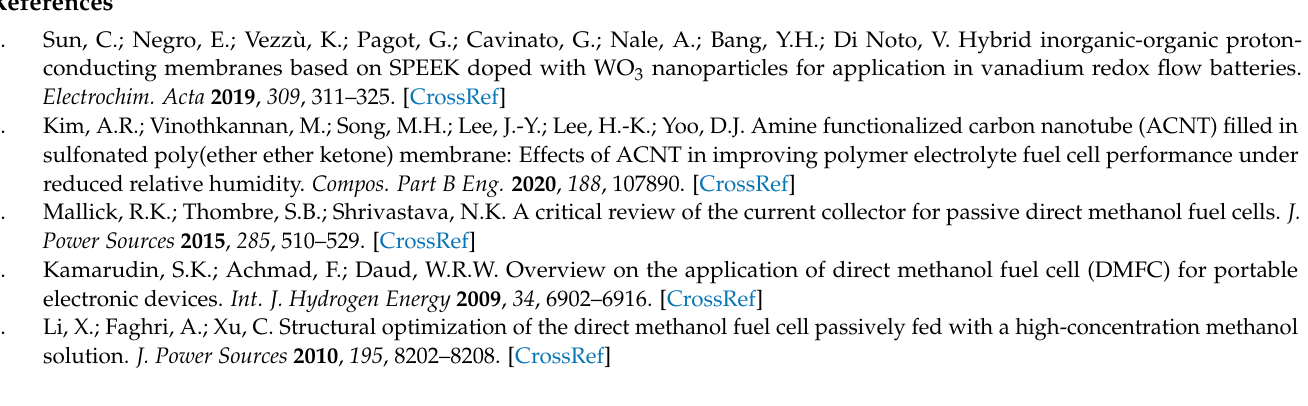
Figure S2: The Pt-sputter coating method; Figure S3: The assembly of the PEFCs using ESM; Figure S4: The chemical stability of the pristine ESM to strong acids (HCl and H 2 SO 4 ). Figure S5: SEM images of the front (a) and back (b) of the pristine ESM. The ESM has the interwoven fiber structure with too tiny pores to observe by using SEM; Figure S6: The I – V curve of the FC using Nafion; Table S1: Comparison of performances among the ionomer-free